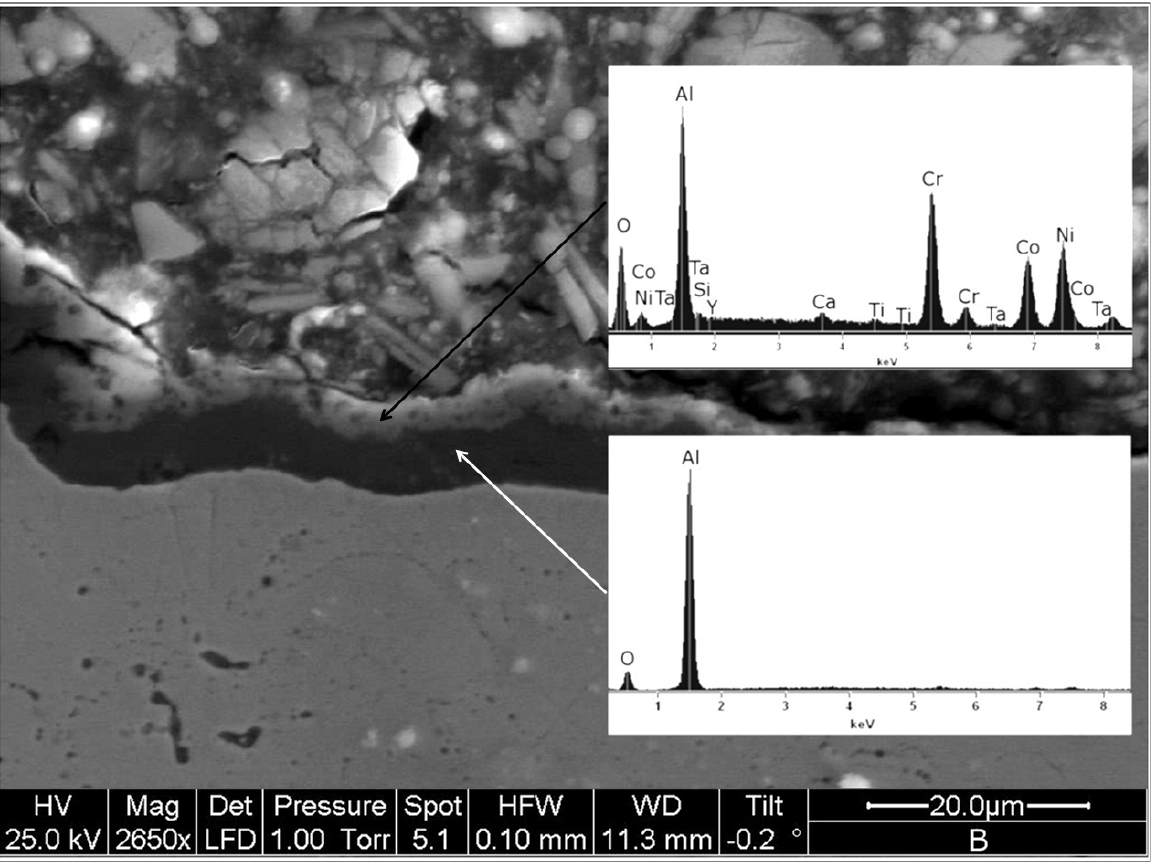
Figure 7. The TGO bi-layered structure relative to sample B oxidized at 1,273 K for 5,000 h. The arrows indicate the regions where EDX analyses were performed.